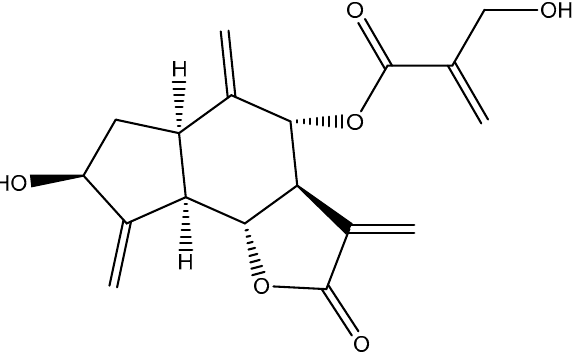
Figure 1. Chemical structures of cynaropicrin.